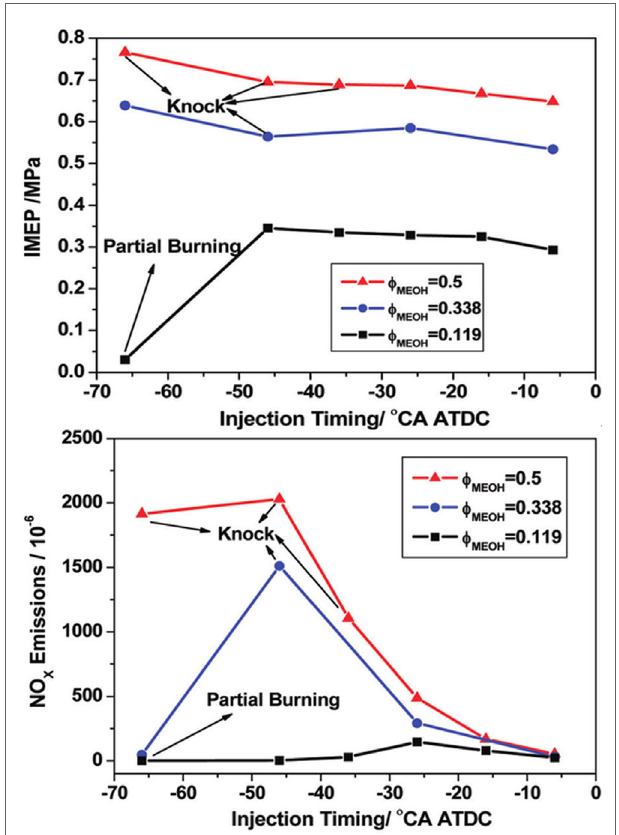
FiGURe 7 | effects of methanol injection timing and concentration on iMeP and NOx emission in thermal-atmosphere controlled combustion mode .